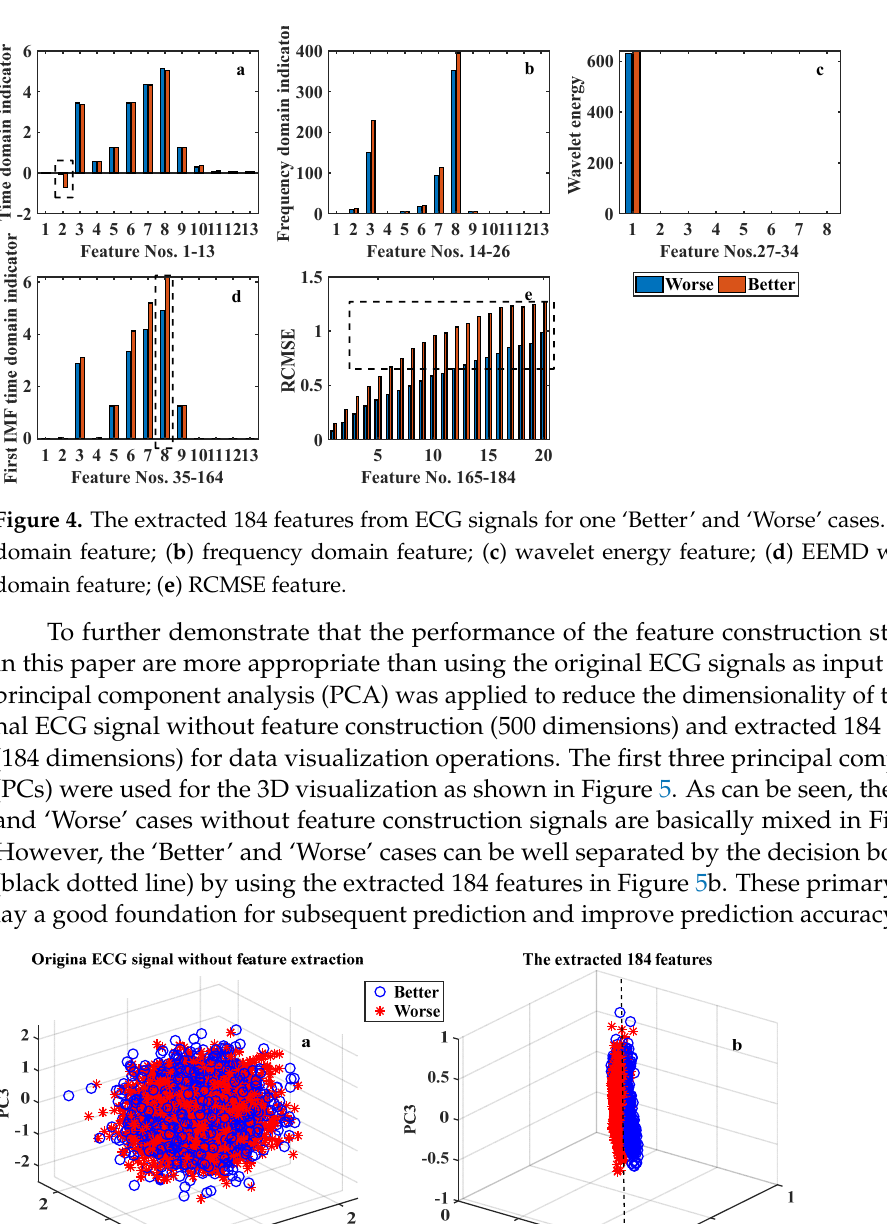
Figure 5. The result of the PC1-PC3 via PCA from the original ECG signals and 184 features.